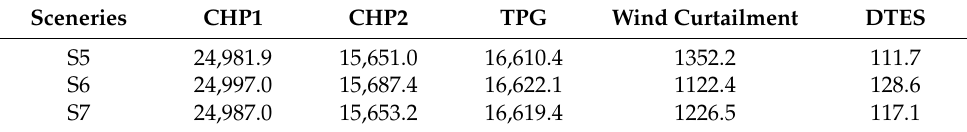
Table 6. Composition of annual operation and maintenance cost of